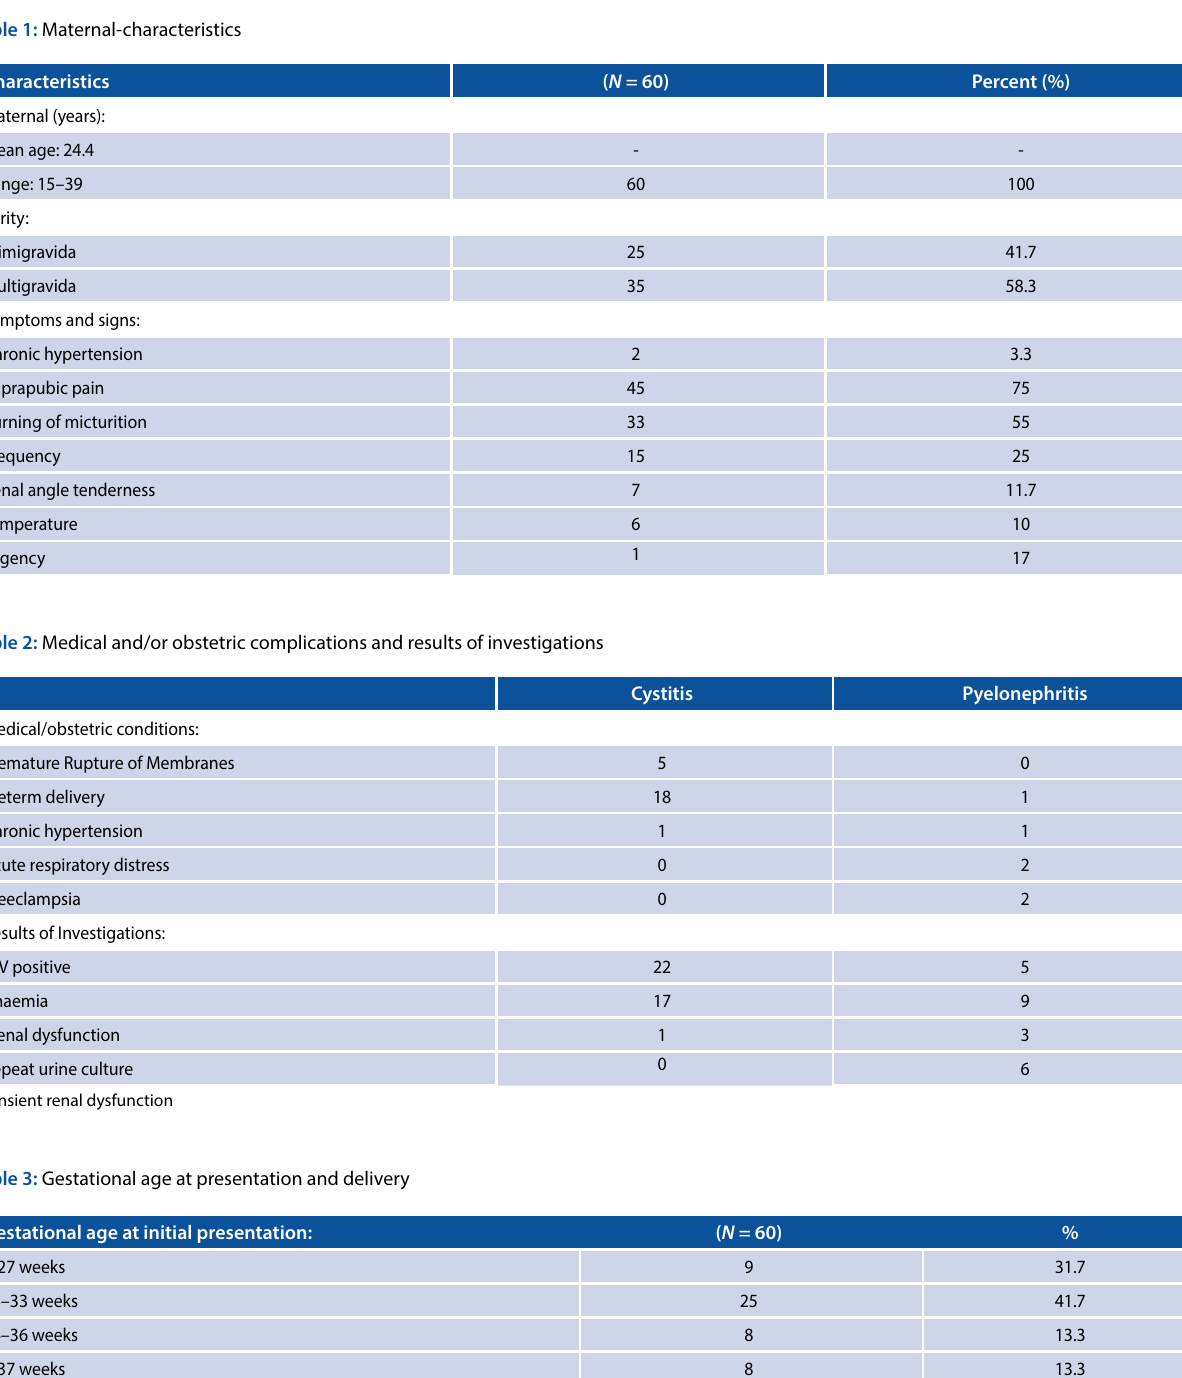
Table 1: Maternal-characteristics Characteristics